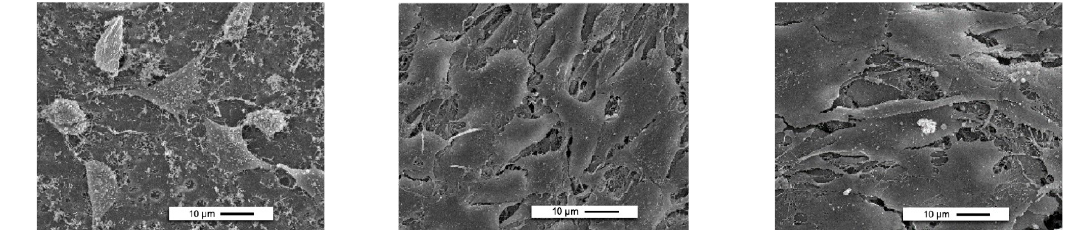
Figure 10. SEM images obtained of 20% ( w / v ) GelMA solution-based hydrogels seeded with ATDC5 cells at ×1.500 magni fi cation.